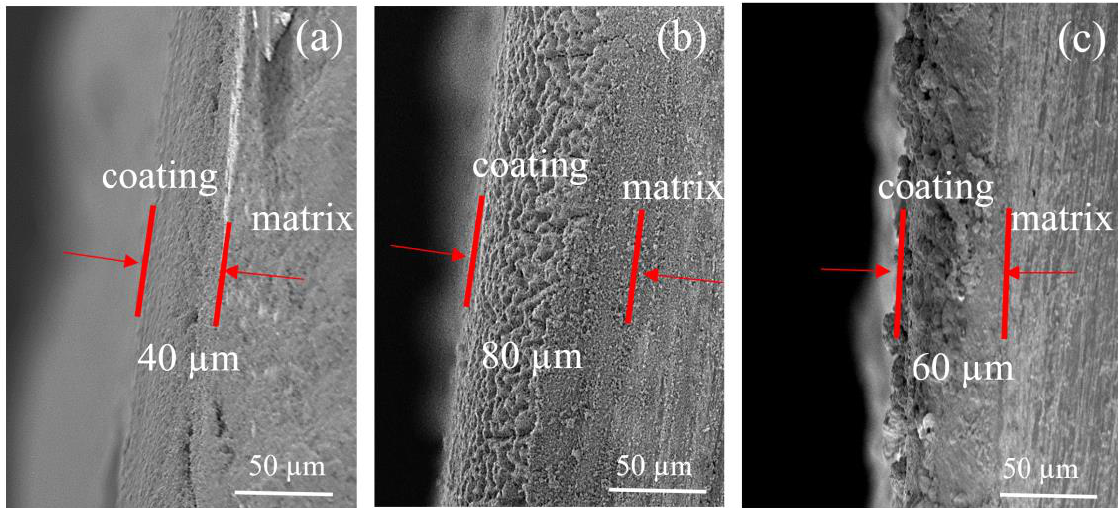
Figure 3. Cross-sectional SEM morphologies of the EPD 90 s coated magnet. ( a ) Without Mg 2+ and Cu 2+ ; ( b ) with Mg 2+ ; ( c ) with Cu 2+ Cu 2+ ; ( b ) with Mg 2+ ; ( c ) with Cu 2+ .